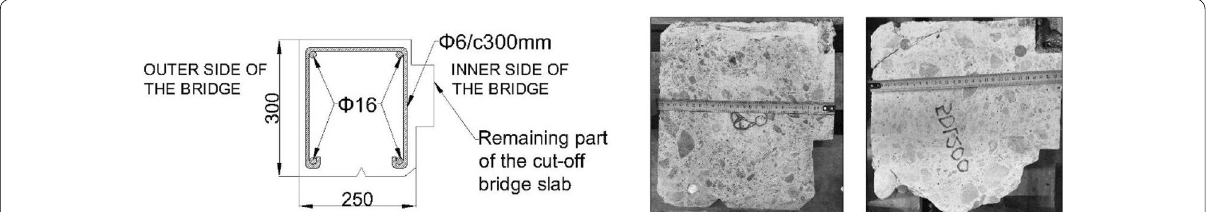
Fig. 7 The geometry of the cross-section (according to the original drawings) and two different cross-sections of the edge beams. The remaining part of the cut-off bridge slab is clearly visible to the right. Dimensions are in